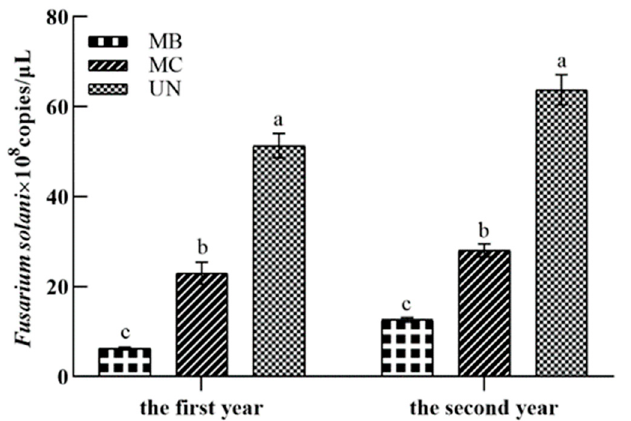
Figure 5. Effect of mixed cropping grafted apple seedlings for two years with A. fistulosum L. on the Fusarium solani isolate HBH 08 in the soil. MB, replanted soil treated with methyl bromide fumigation (high standard control); MC, replanted soil with Allium fistulosum L. (5 g of seeds were sown on each tree tray.); and UN, replanted soil as a control. Different letters (a, b, and c) indicate significant differences according to Tukey’s HSD test.